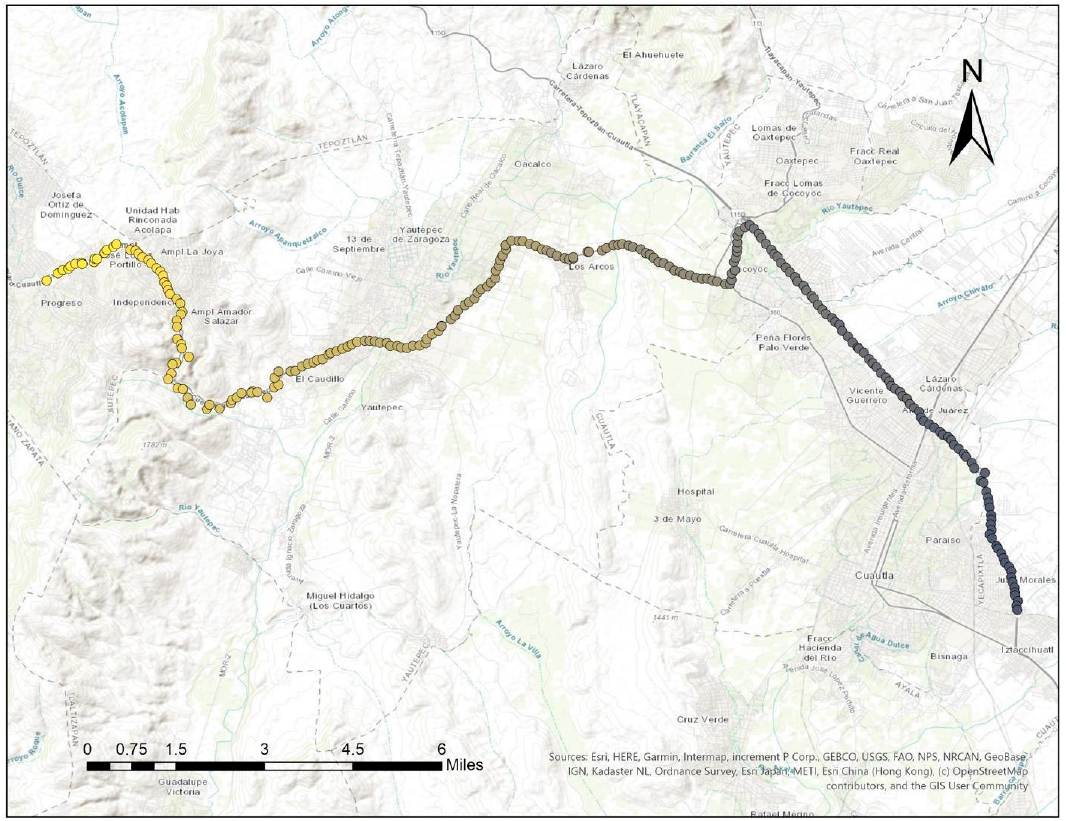
Figure 2. The path of one unique ID in the state of Guerrero, Mexico on 22 September 2017. Lighter colors indicate locational points from earlier in the day. This number of pings in one day is unusual but illustrative of the spatiotemporal richness of the data.